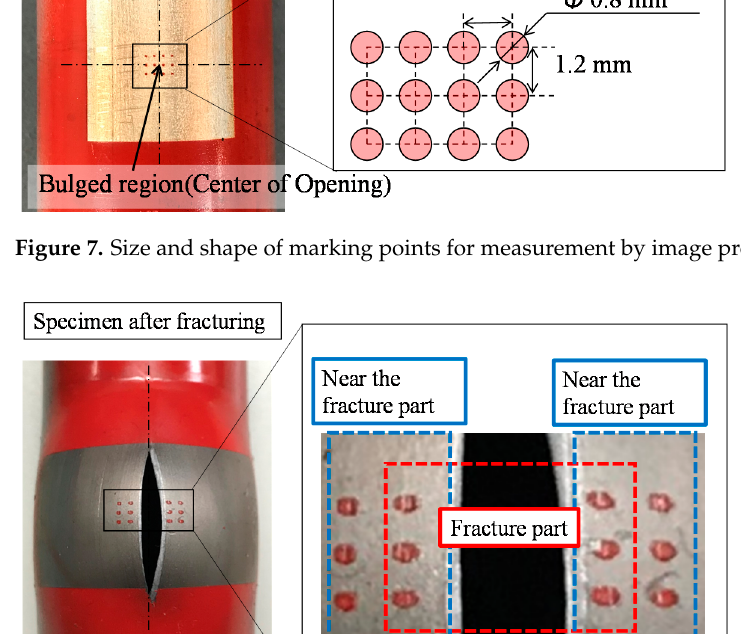
Figure 10. Size and position of slits.